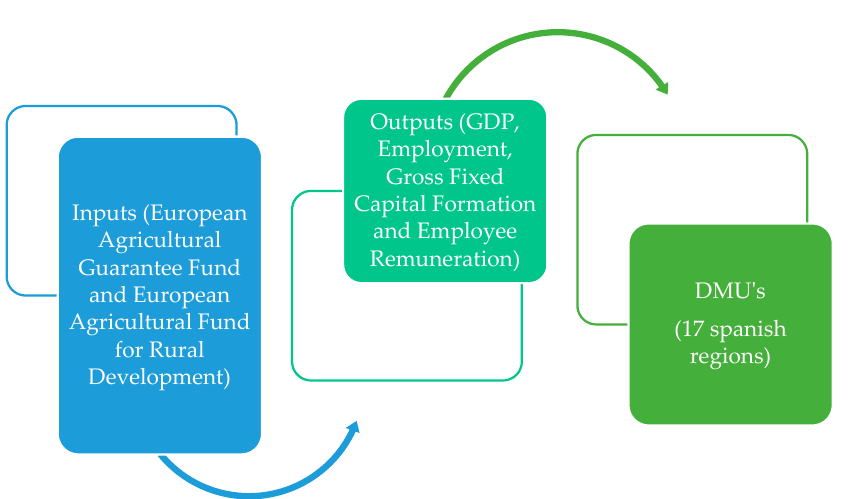
Figure 6. Summary of the applied methodology (Source: Authors’ own elaboration).